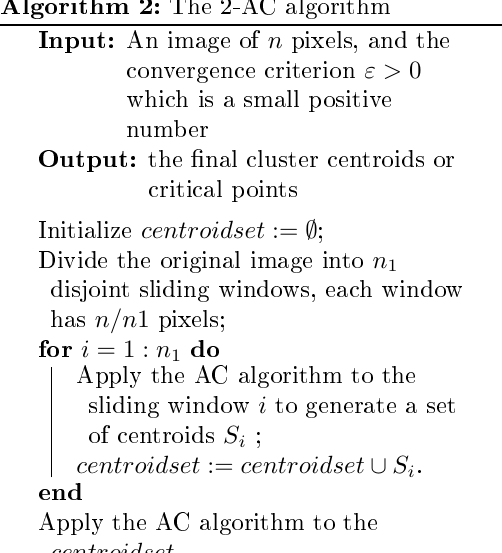
Algorithm 2: The 2-AC